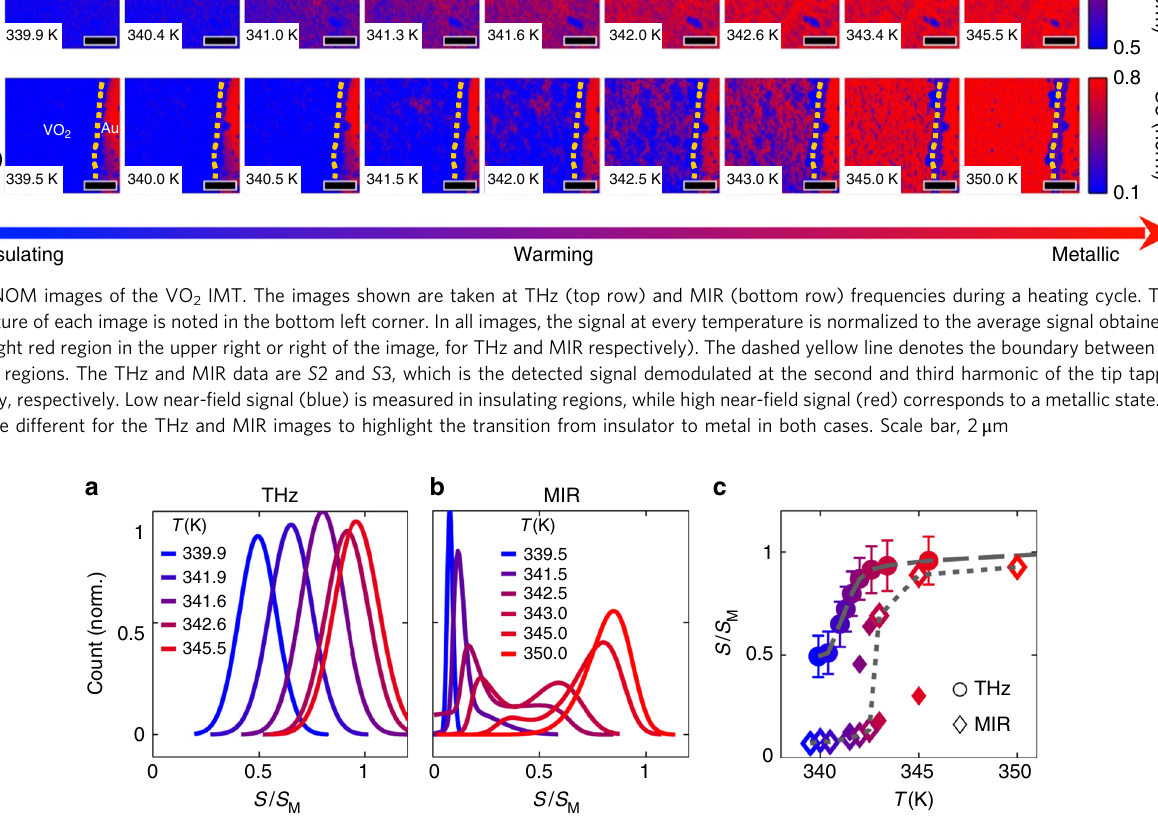
discontinuously with temperature. In the case of an IMT, that order parameter describes the metallicity of the material, and is closely related to the density of states (DOS) at the Fermi level 33 .